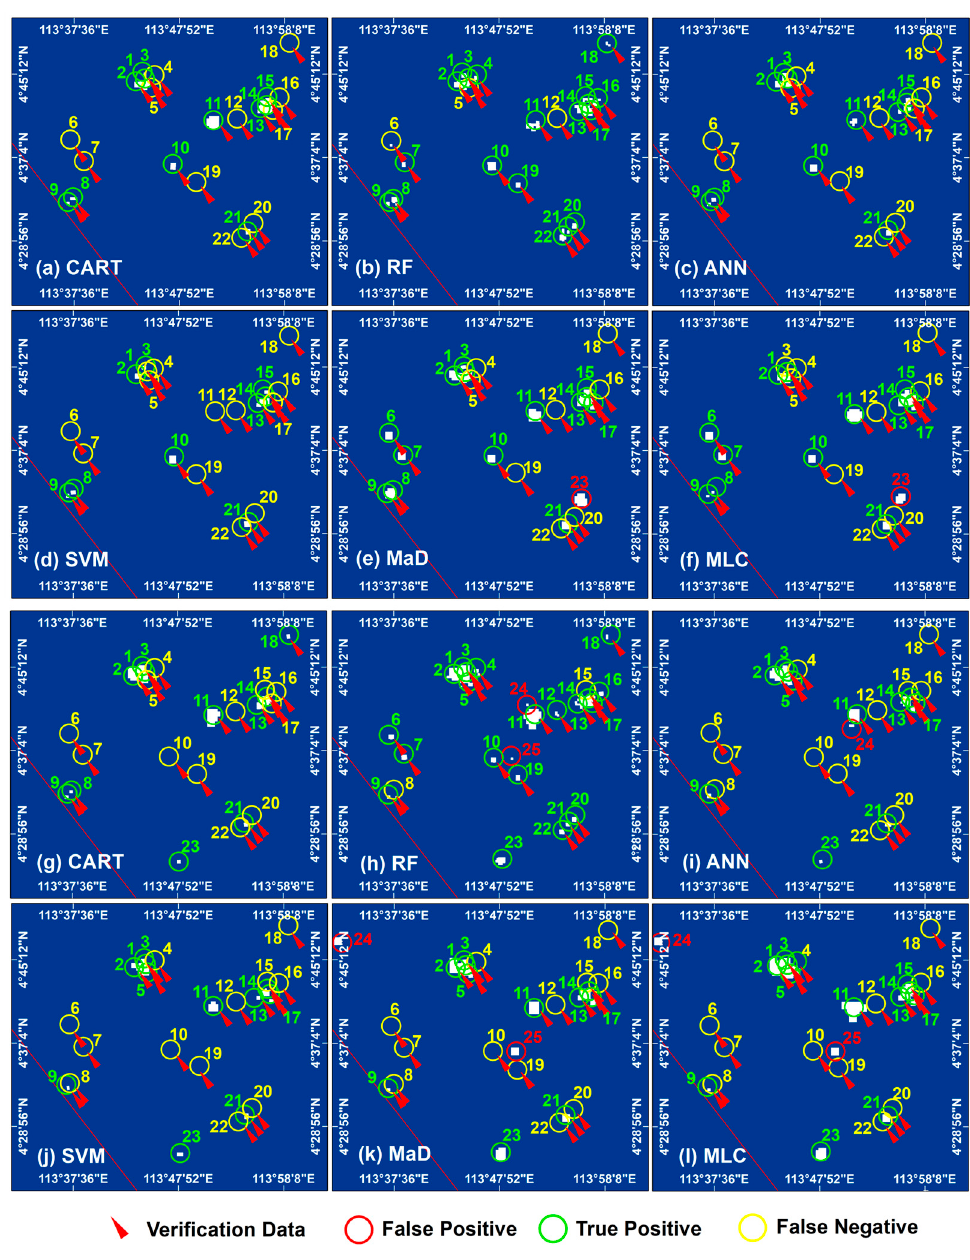
Figure 9. Extraction results of the targets in region 4, located in the Brunei-Sabah Basin: ( a – f ) are the extraction results in 2016; ( g – l ) are the extraction results in 2017. Red arrows are the validation targets; green circles are the correctly extracted targets; yellow circles are the omissive targets; and red circles are the incorrectly extracted targets.